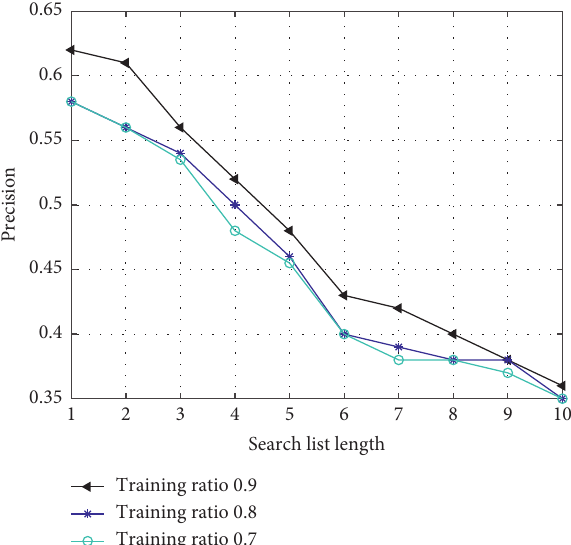
Figure 6: Search filtering accuracy of discriminative english grammar training.